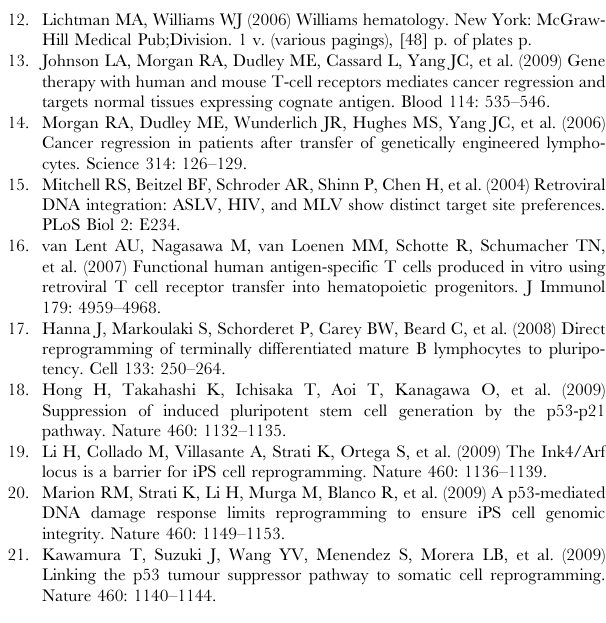
Figure S1 DNA Fingerprinting. Short Tandem Repeat (STR) analysis shows TiPS cell lines are identical to parent activated T-